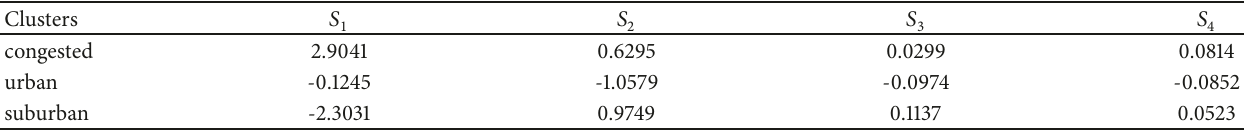
Table 5: Principal component cluster centers.